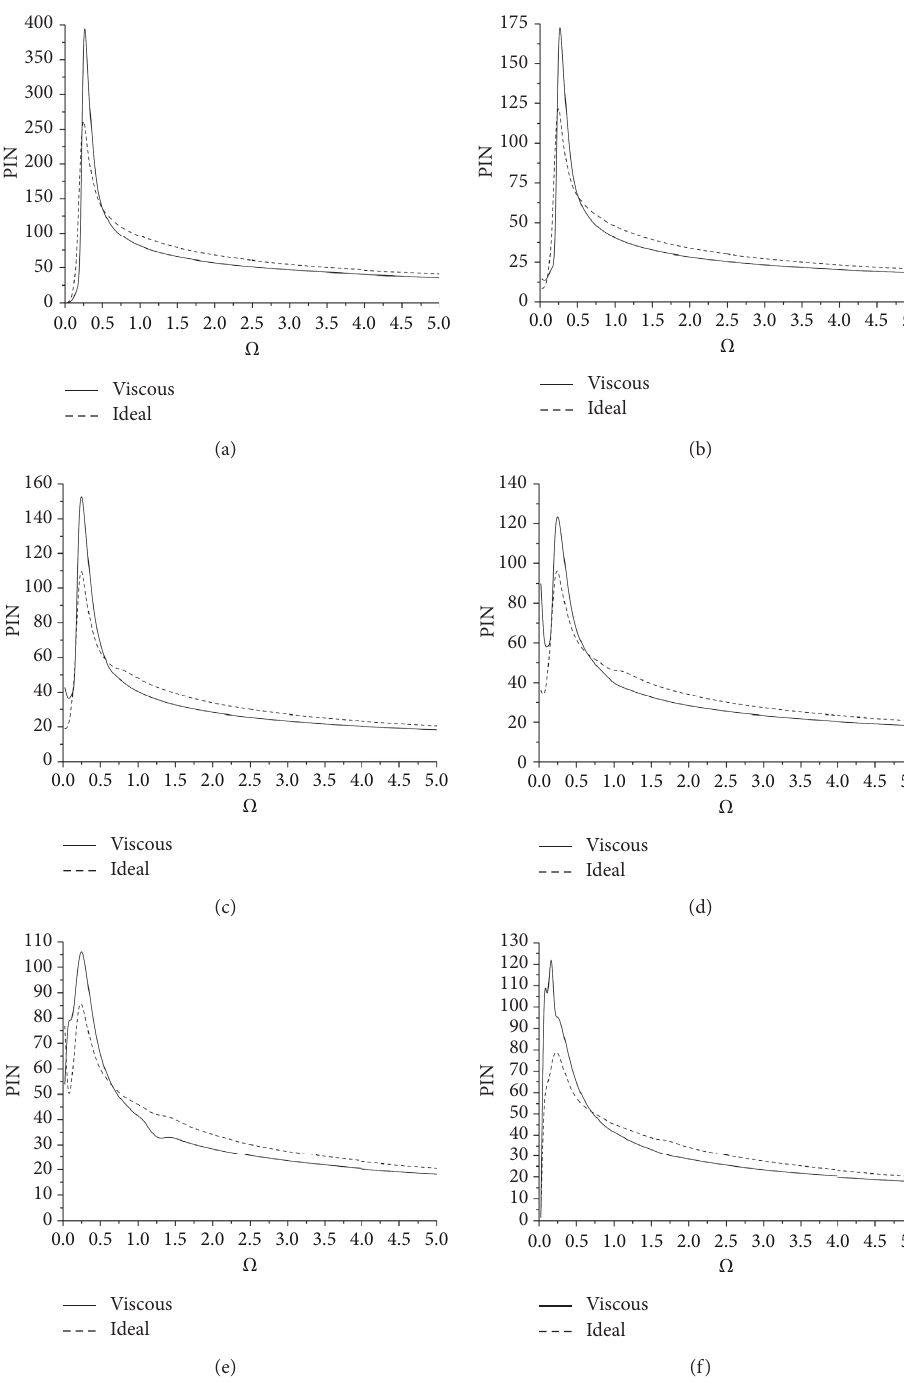
Figure 3: Input power flow in ideal and viscous fluids. (a) n � 0. (b) n � 1. (c) n � 2. (d) n � 3. (e) n � 4. (f) n �